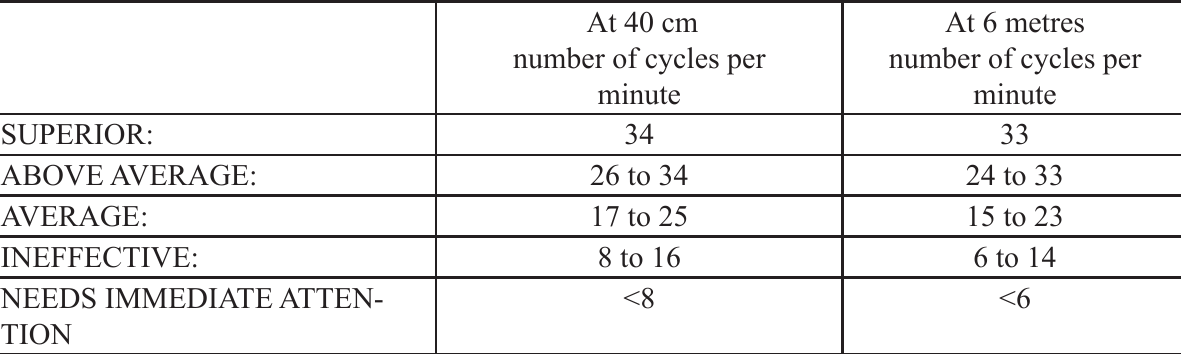
At 40 cm At 6 metres number of cycles per number of cycles